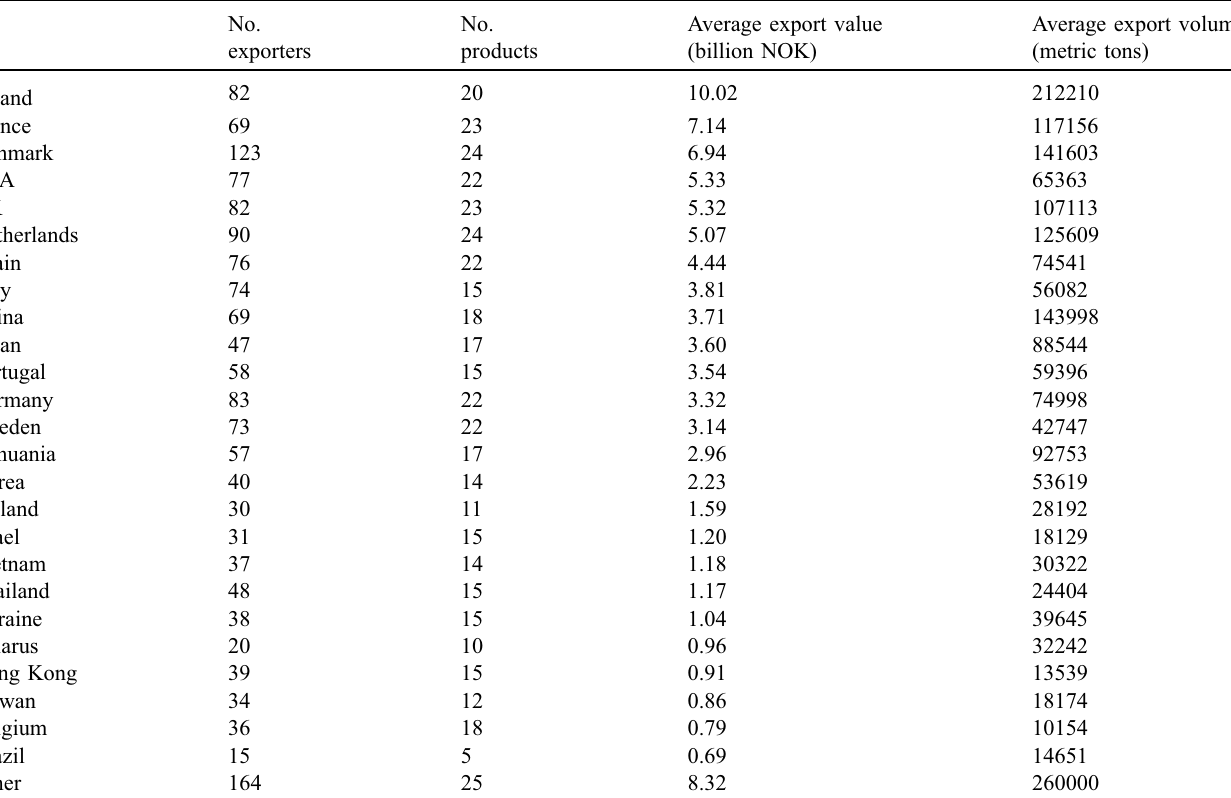
Table 2. Descriptive statistics. 25 largest export markets. Annual averages for 2016 –